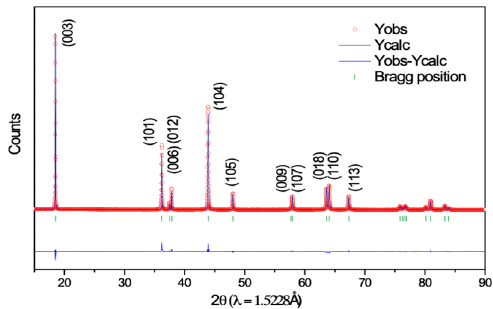
Figure 1. Rietveld refinement of the synchrotron high-resolution powder diffraction patterns of NCM811 cathode material prior to electrochemical testing.